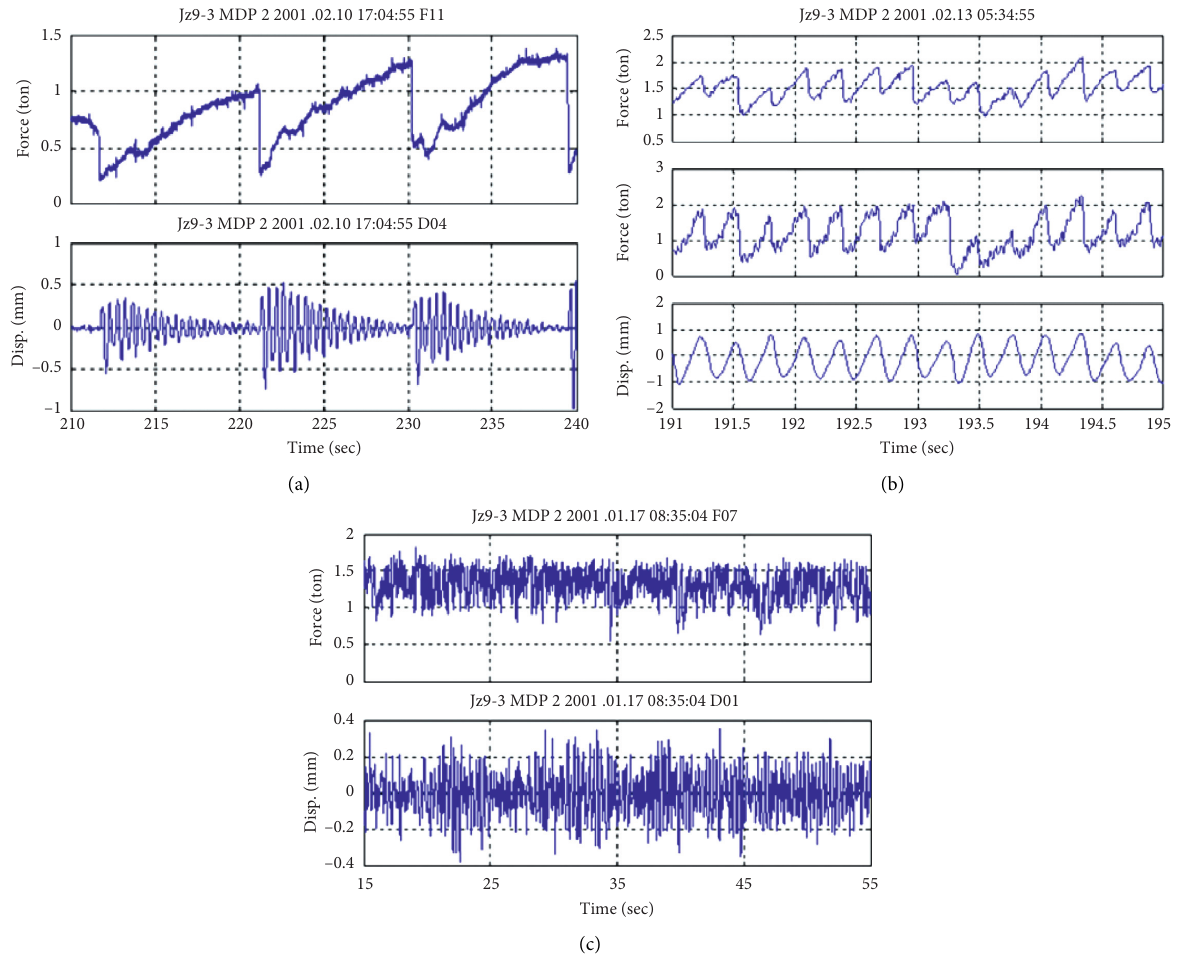
Figure 1: Ice loads and structure responses [11]. (a) Quasistatic. (b) Steady-state. (c)